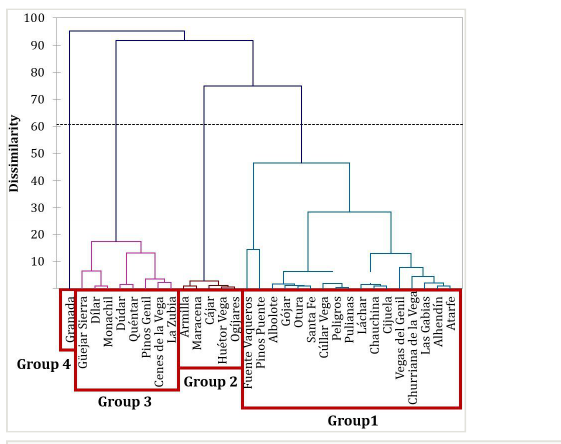
Hierarchical cluster analysis results, showing the four groups of municipalities (see Suppl. materials 2-3 for a more detailed information).